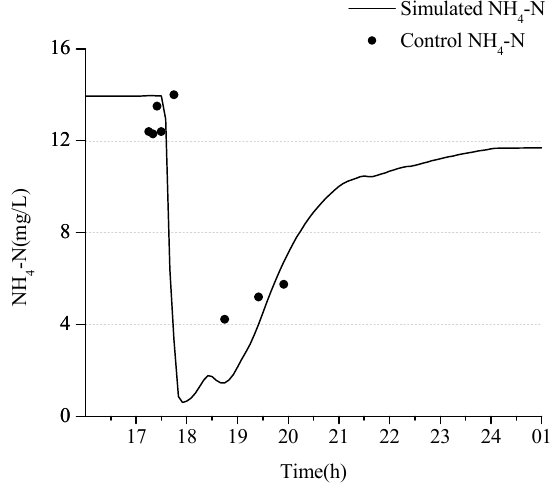
Figure 2. Fitting diagram of sewage flow in dry season.